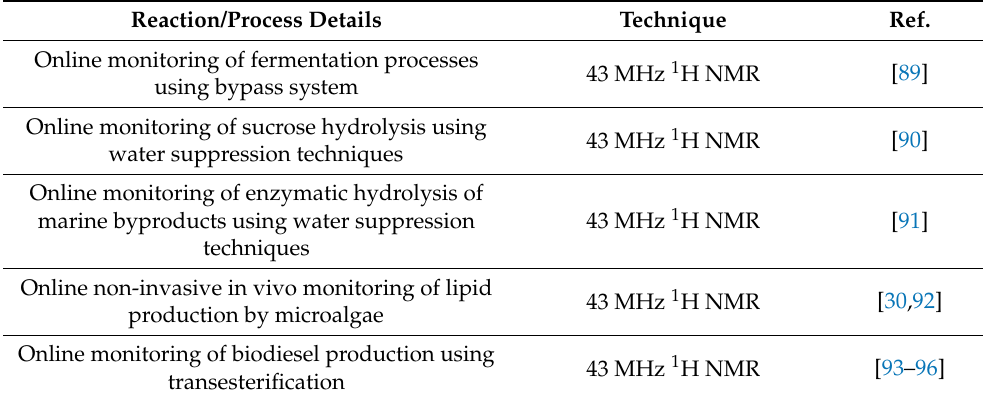
Table 5. Applications of benchtop NMR spectroscopy to bioprocesses